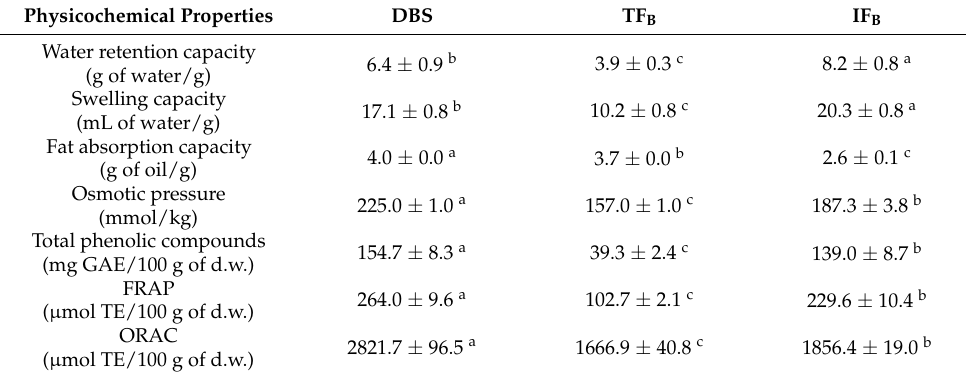
Table 4. Physicochemical properties, content of total phenolic compounds and antioxidant capacity of samples obtained from broccoli stalk